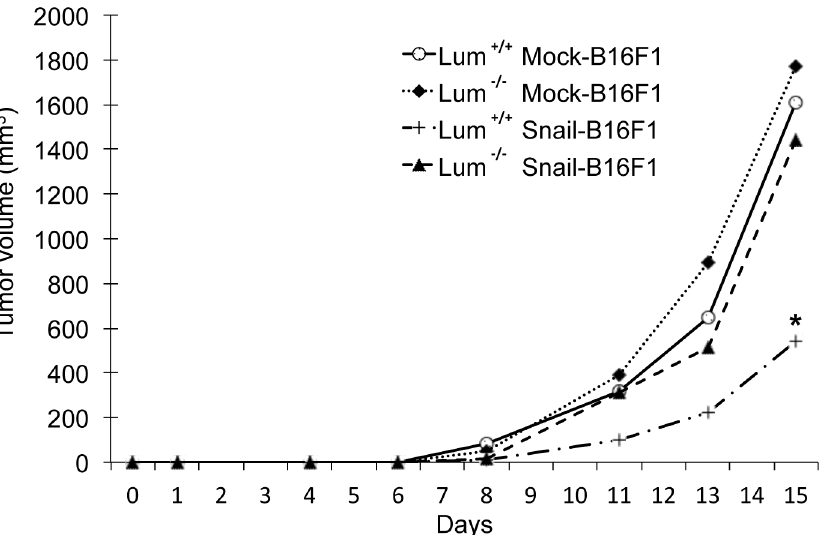
Fig 6. Lumican inhibits melanoma primary tumor growth of Snail overexpressing B16F1 cells in vivo . Lum +/+ and Lum -/- mice on the C57Bl/6 background were injected subcutaneously with 2.5 x 10 5 of B16F1 cells, mock or Snail overexpressing B16F1 cells (clone Snail19-B16F1). The kinetic of melanoma primary tumor growth is displayed in volume (mm 3 ) till day 15 when mice were sacrificed. * p < 0.05: significantly different from mock-transfected B16F1 cell tumors, Open circle: wild type C57Bl/6 mice injected with mock- B16F1 cells (n = 10); Diamond: lumican deleted C57Bl/6 mice injected with mock B16F1 cells (n = 10); Open square: wild type C57Bl/6 mice injected with Snail overexpressing B16F1 cells (n = 10); Triangle: Lumican deleted C57Bl/6 mice injected with Snail overexpressing B16F1 cells (n = 10).